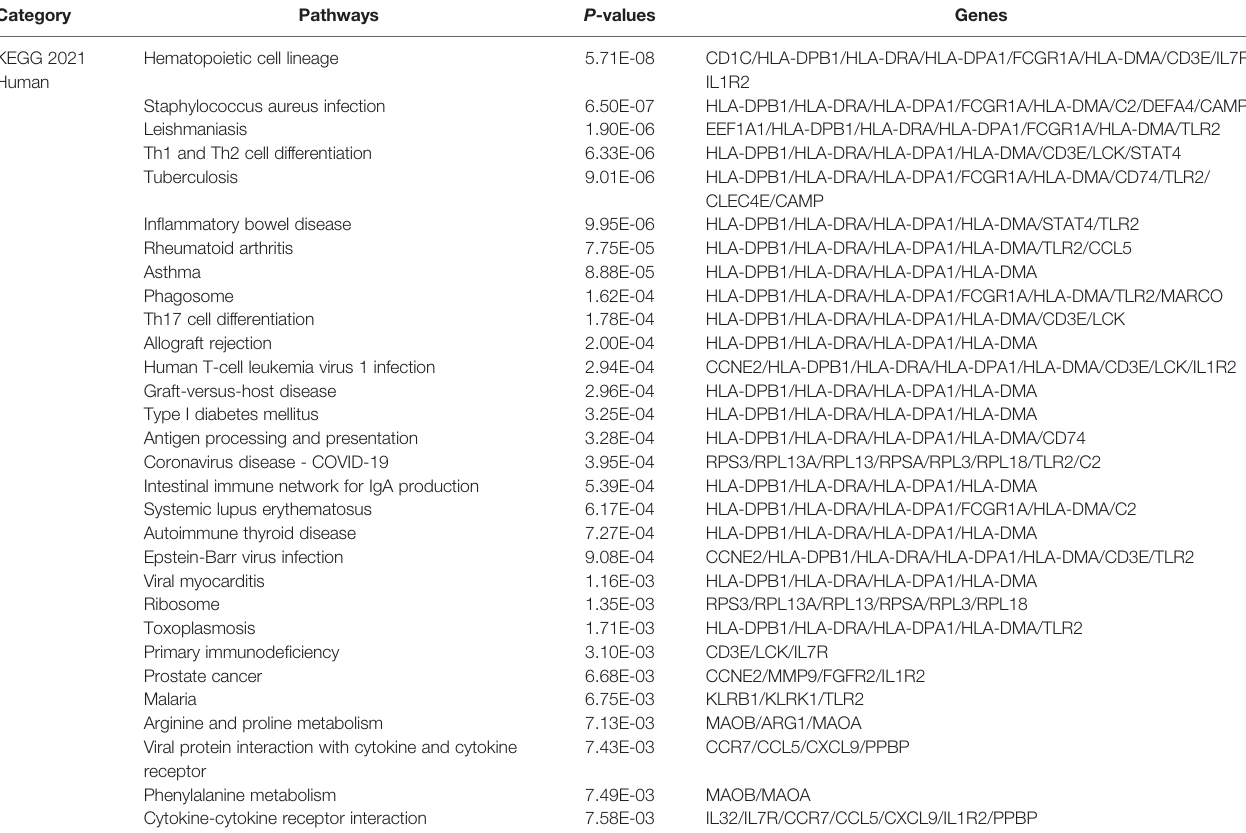
TABLE 3 | Pathway enrichment analysis of common DEGs among COVID-19 and RA. Pathways P -values